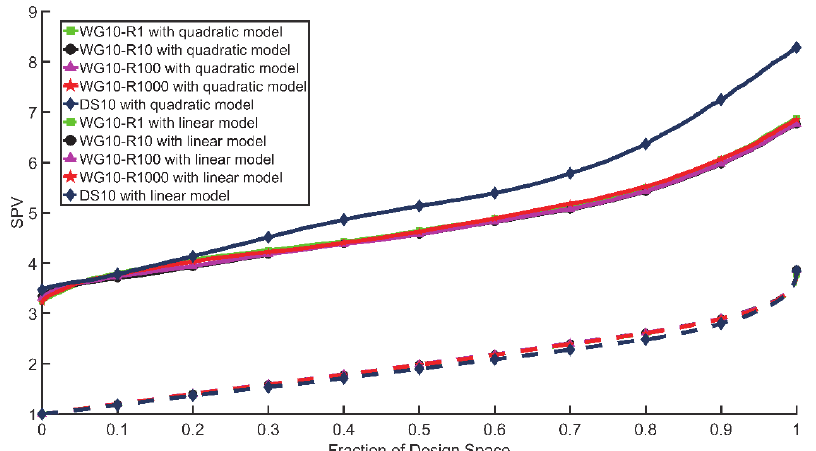
Fig. 2. FDS plot for comparing the WG10 designs and the EA designs for the Scheffé quadratic and linear models for the poultry